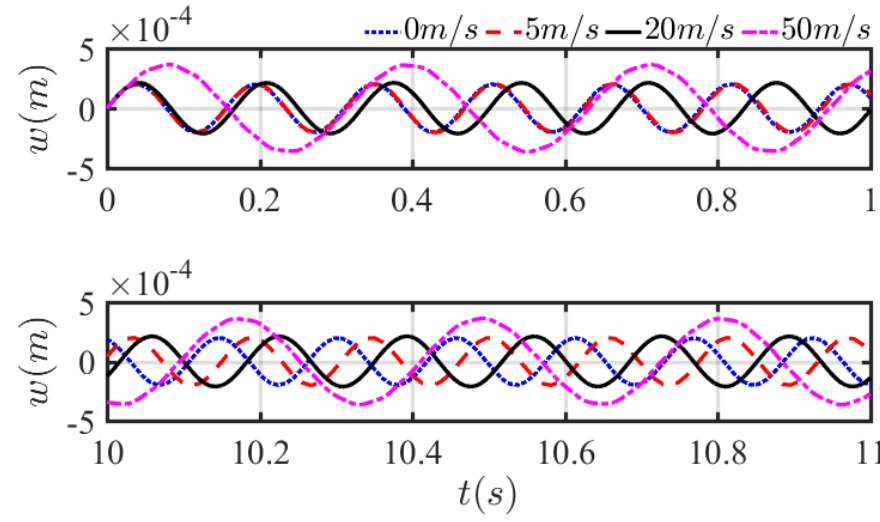
Figure 12. Effects of flow rates on the nonlinear transient vibration of GPLRC pipes conveying fluid.